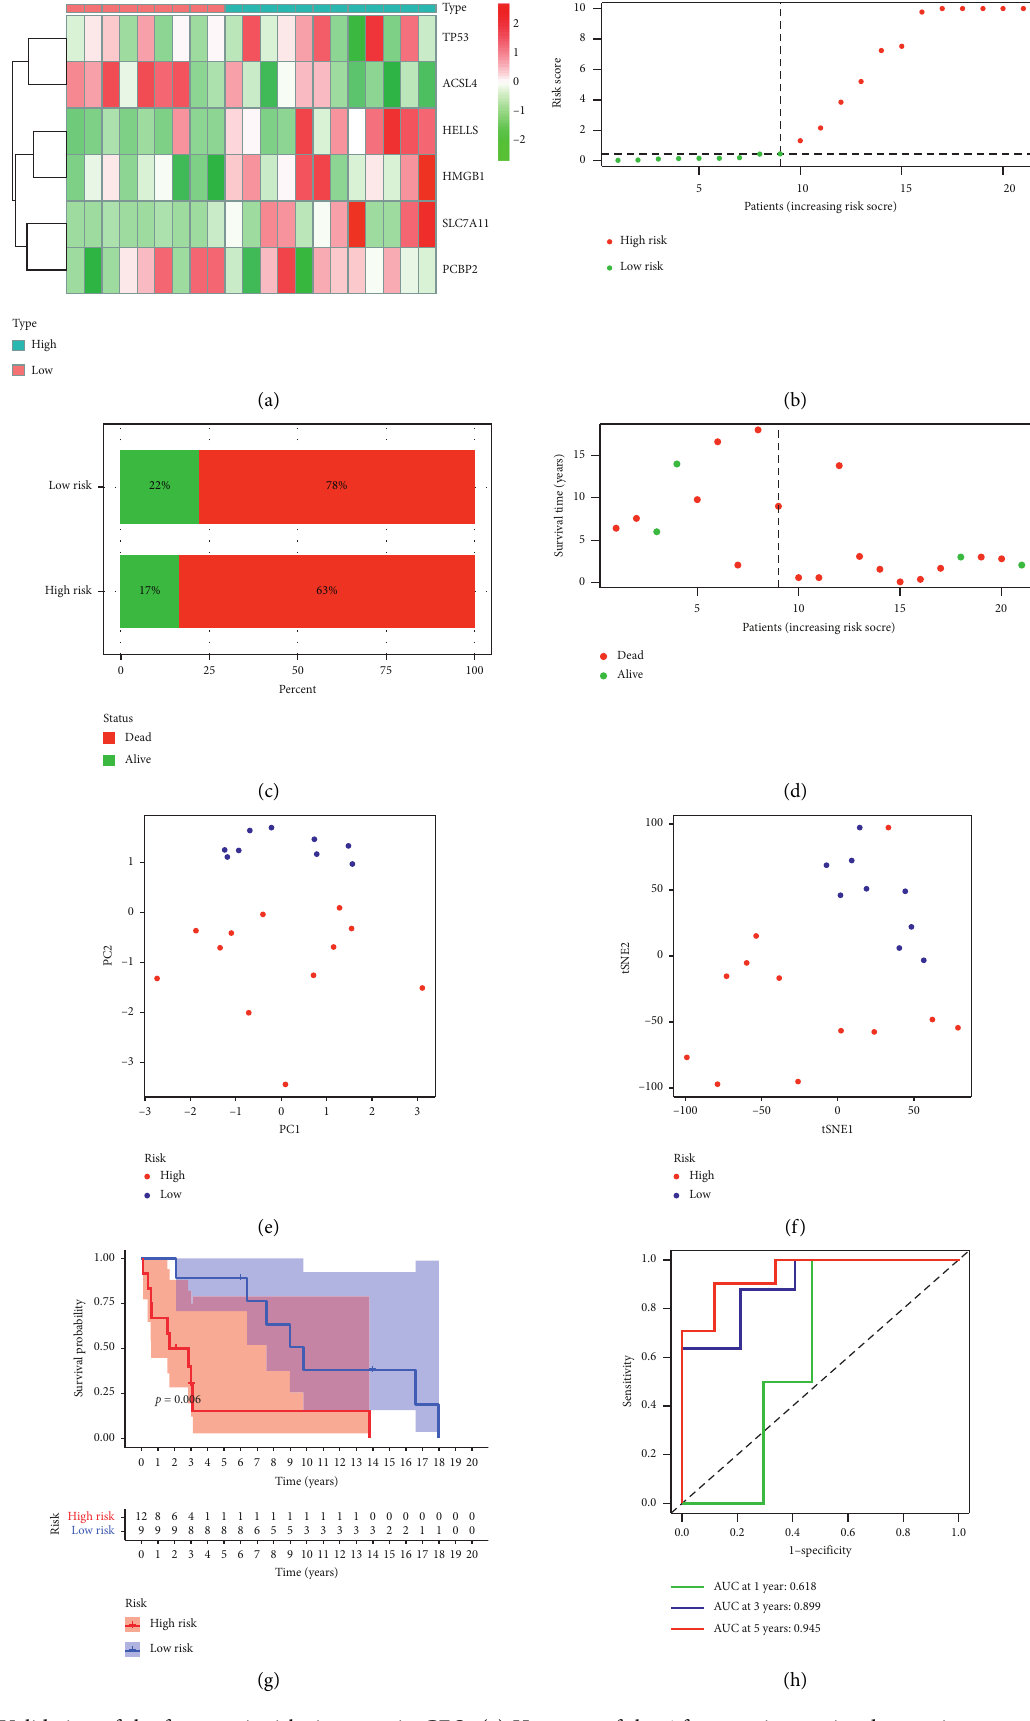
Figure 3: Validation of the ferroptosis risk signature in GEO. (a) Heatmap of the 6 ferroptosis-associated genes in two groups. (b) The distribution and median value of the risk scores. (c), (d) The mortality in two groups. (e) The PCA plot. (f) The t-SNE analysis. (g) K-M curves for the OS of patients in two groups. (h) ROC curve for evaluating the prognostic effect of the risk